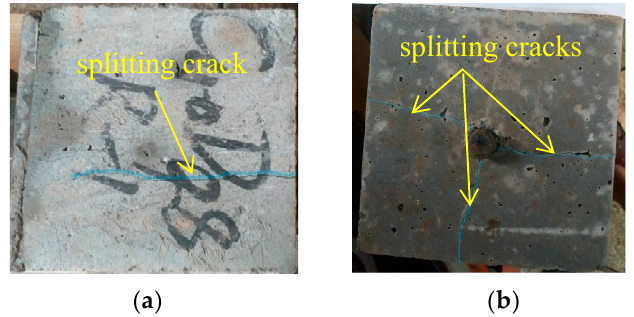
Figure 2. Splitting failure of concrete: (a) on the side surface; (b) on the bottom surface. Figure 5. Splitting failure of concrete: ( a ) on the side surface; ( b ) on the bottom surface.